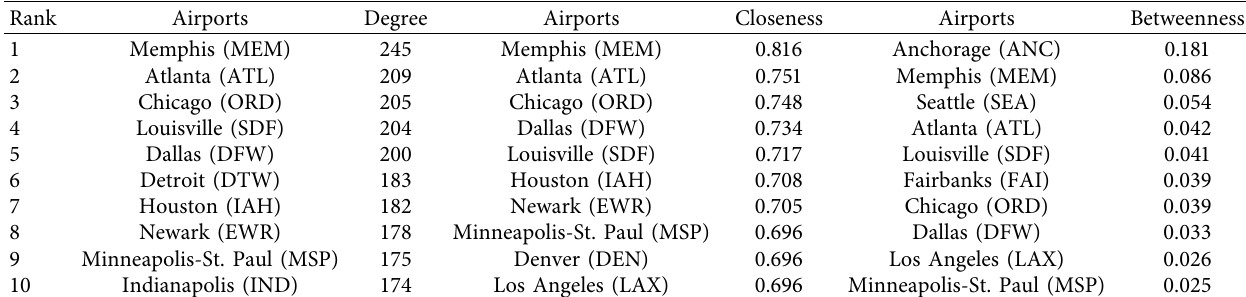
Table 4: Rankings of the US air cargo airports based on complex network metrics in 2010.